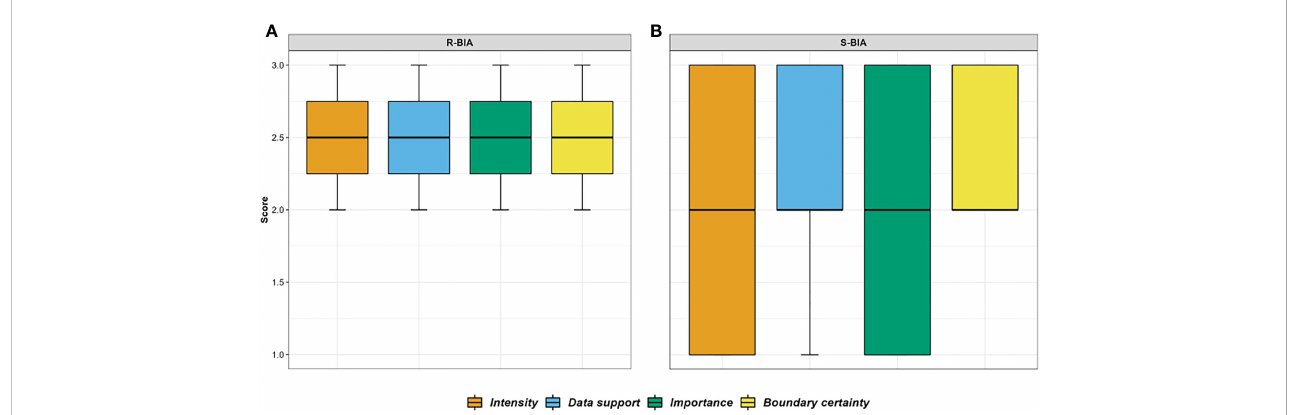
FIGURE 10 Hawai ʻ i BIA score summary boxplots by BIA type ( A : reproductive BIA; B : small and resident BIA). The thick black bar in the middle of each box plot represents the median value; the lower and upper hinges of the boxplots correspond to the fi rst and third quartiles; the upper and lower whiskers extend from the quartiles to the largest (lowest) value no further than 1.5 times the interquartile range. Watch list area scores were not included in this